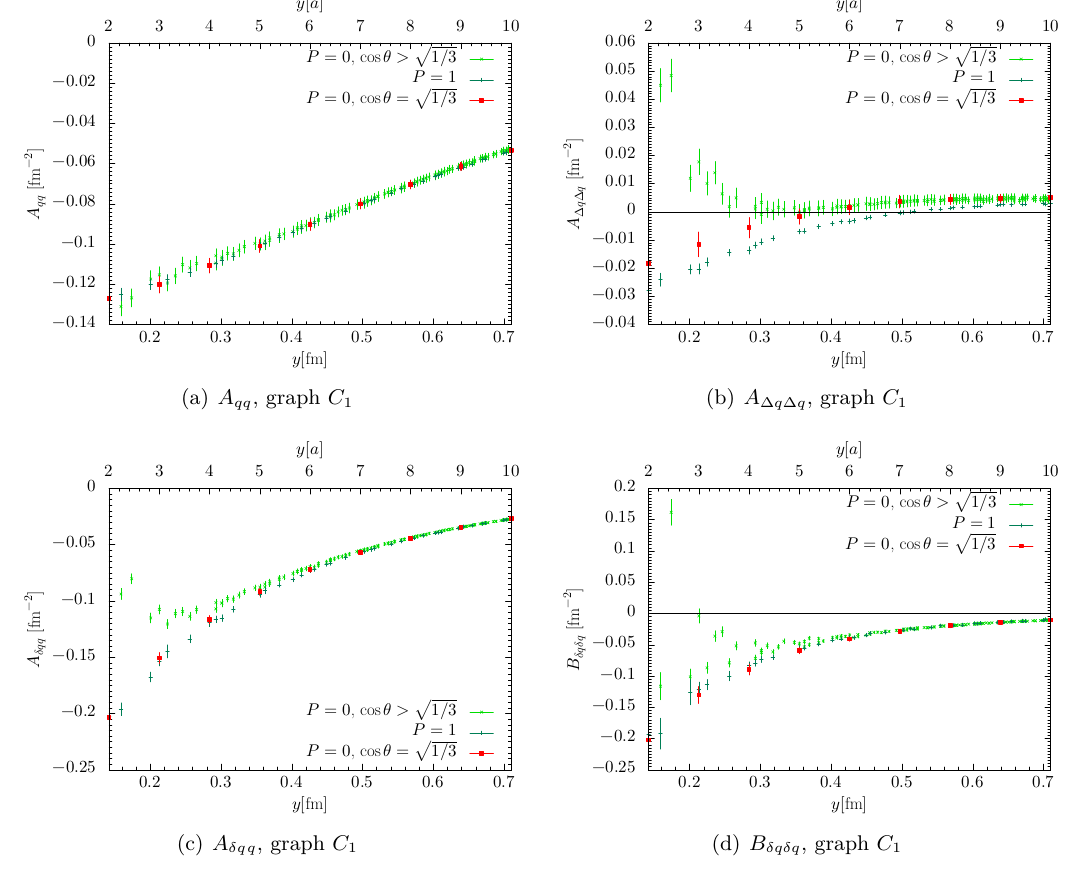
Figure 6 . Twist-two functions at small y for graph C 1 , with scaled pion momenta P = 0 and P = 1 as defined below (3.4). All points have py = 0 and are for L = 40 and light quarks. The √ √ data for P = 2 , P = 3 and P = 2 agree with those for P = 1 within errors but are not shown p for the sake of clarity. Data with cos θ = 1 / 3 correspond to ~y on a coordinate axis.